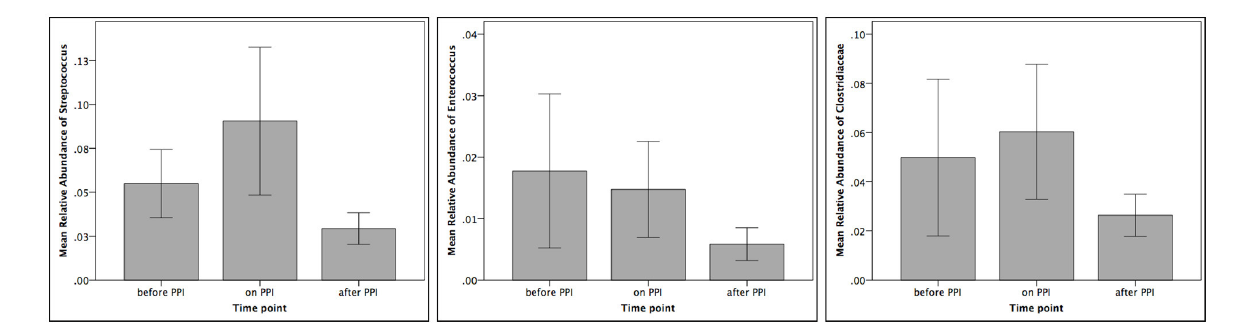
Frontiers in Cellular and Infection Microbiology |